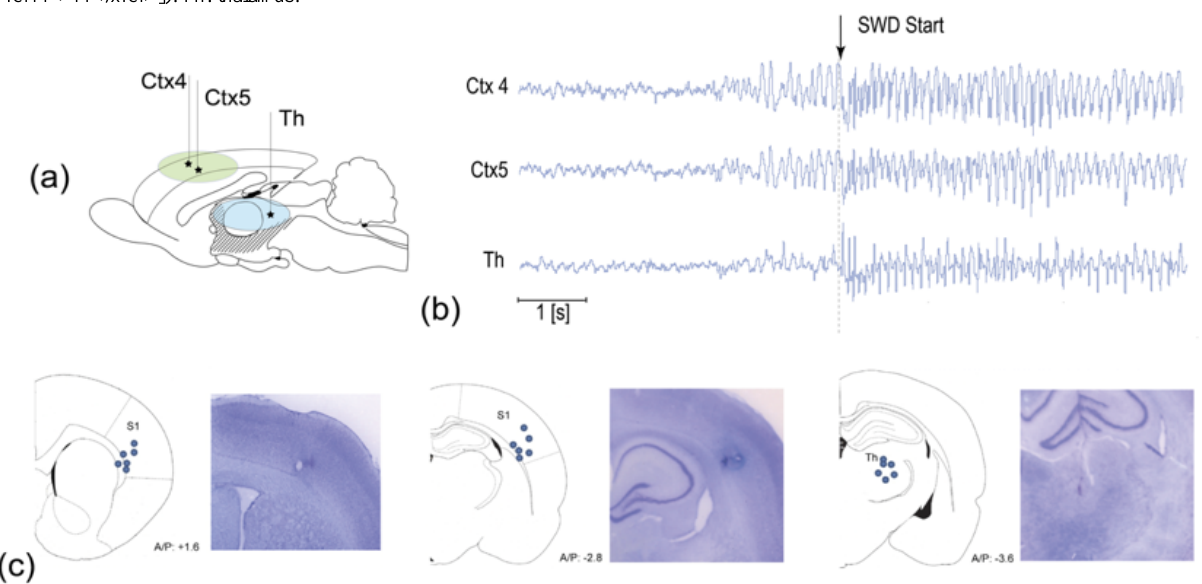
Figure 2. (a) Schematic representation of the experiments with a rat. (b) The set of electrocorticography recordings taken from subgranular layers 4 (Ctx4) and 5 (Ctx5) of the somatosensory cortex and postero/lateral thalamus before and during onset of the epileptic spike-wave discharge. (c) Histological verification of the electrode location in the somatosensory cortex (S1) and postero/lateral thalamus (based on data from [<xref ref-type="bibr" rid="ref11">11</xref>]). Th: